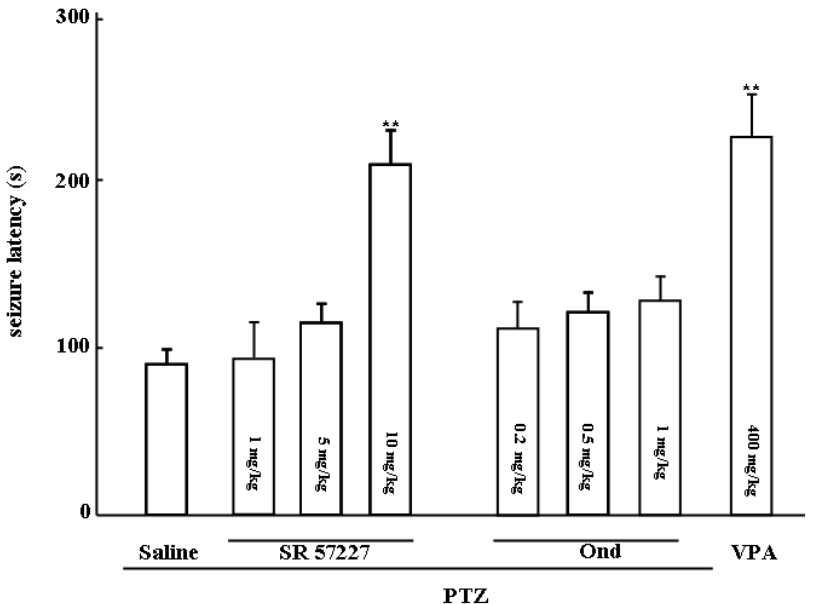
Figure 1. Effects of SR 57227 and ondansetron on seizure latency in PTZ-treated mice. PTZ: pentylenetetrazole (65 mg/kg, i.p.); SR 57227: 1, 5 and 10 mg/kg, i.p.; Ond: ondansetron (0.2, 0.5 and 1 mg/kg, i.p.); VPA: sodium valproate (400 mg/kg, p.o.). Columns represent the mean 6 S.E.M. n = 8–10. ** P , 0.01 vs saline group.